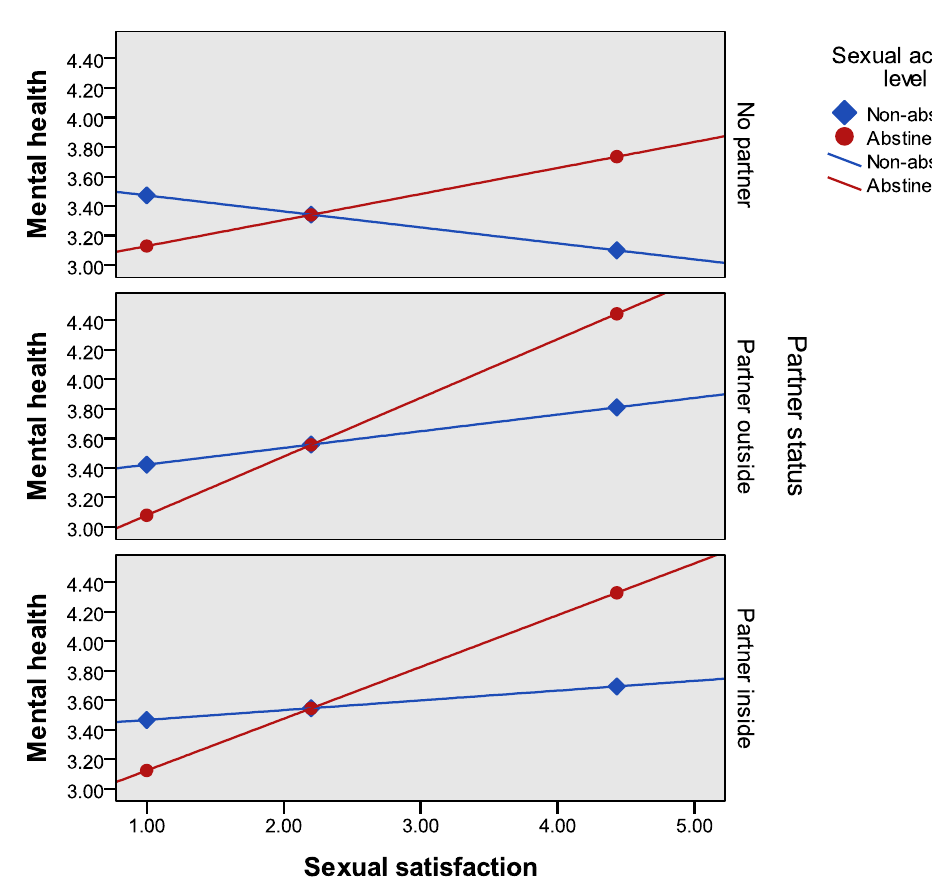
Figure 1. Sexual satisfaction × sexual activity level interaction associated with mental health for three different partner status groups.